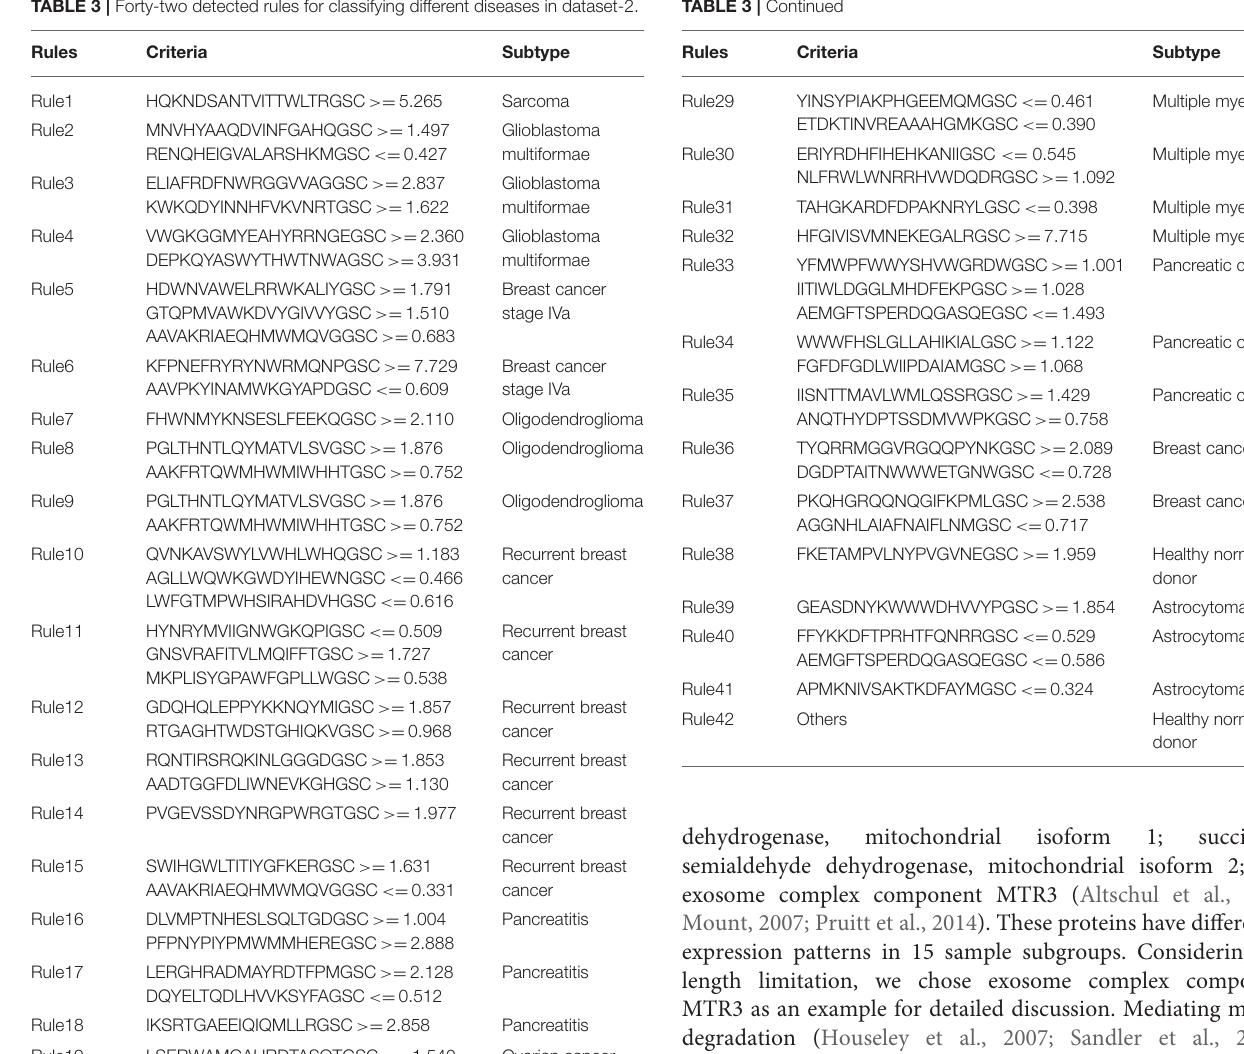
TABLE 3 | Forty-two detected rules for classifying different diseases in